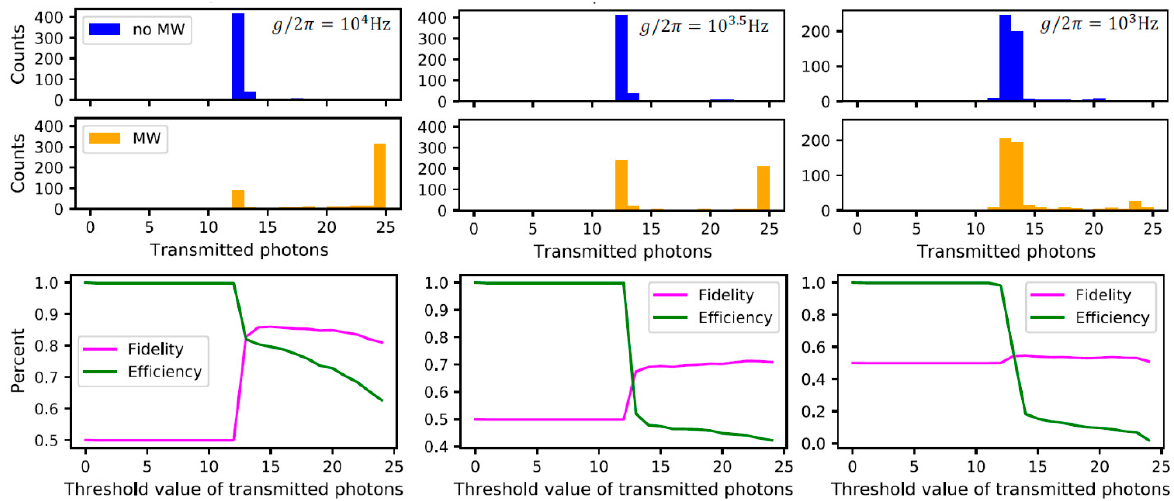
Figure 6. Top row: Results of Monte Carlo simulations. The plots show the number of transmitted photons when 25 photons are incidents on the cavity. The counts correspond to the number of Monte Carlo trajectories. Bottom row: The detection efficiency and fidelity for different choices of the threshold value. When the number of detected photons is above the threshold value, we conclude that a microwave photon is present. The microwave cavity coupling decreases from left to right.